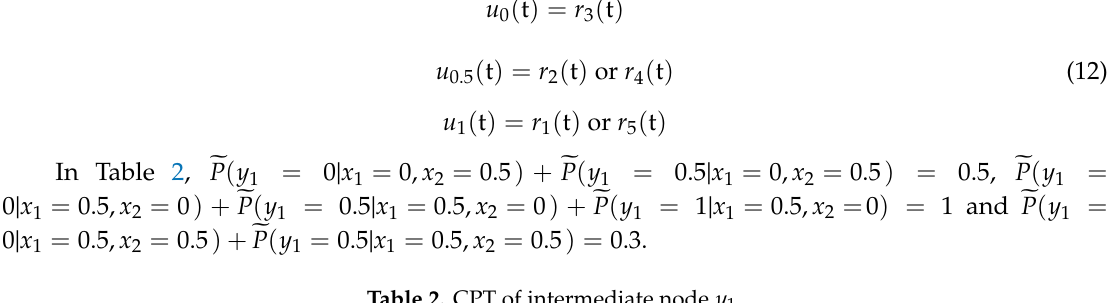
Table 2. CPT of intermediate node y 1